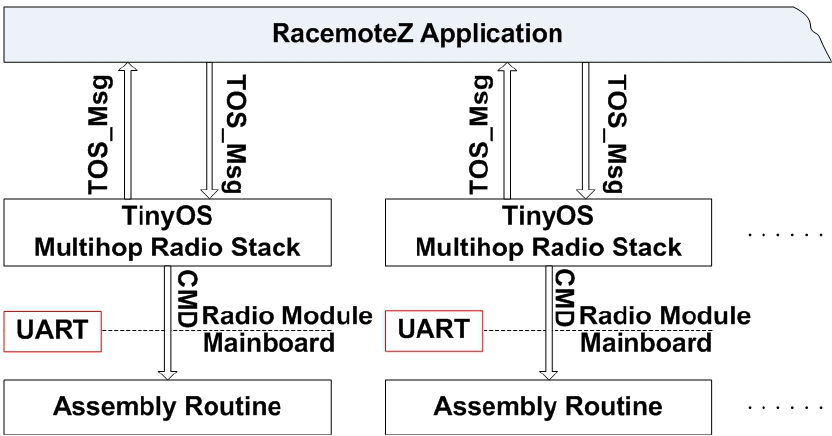
Figure 4. The embedded software modules of the mobile